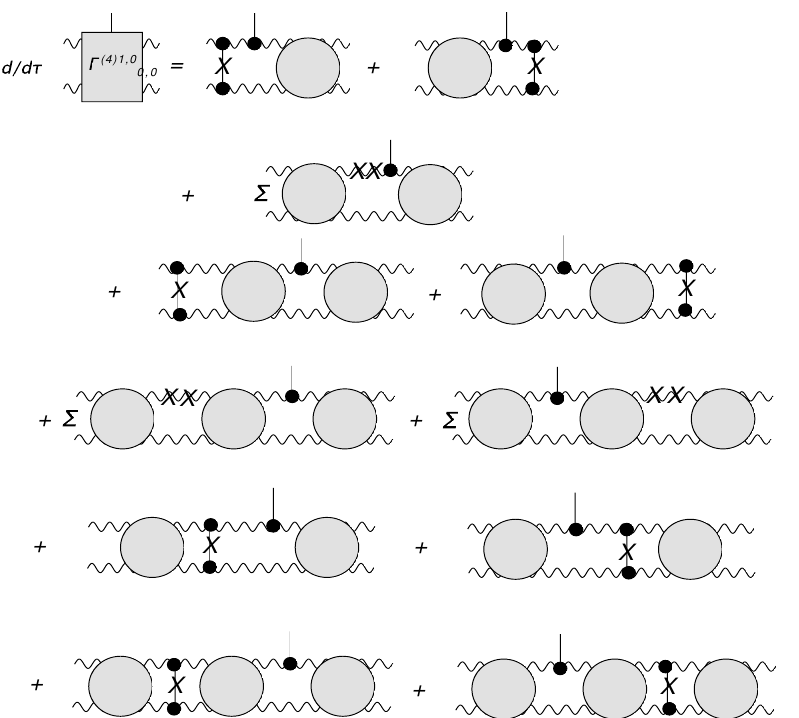
Figure 20 . Modi(cid:12)cation of the (cid:13)ow equation in (cid:12)gure 15. For the terms in the second and fourth lines it is understood that, for the derivative marked by cross we have to sum over all locations on the inner loop (upper and lower reggeon lines, left and right hand side of the production vertex).